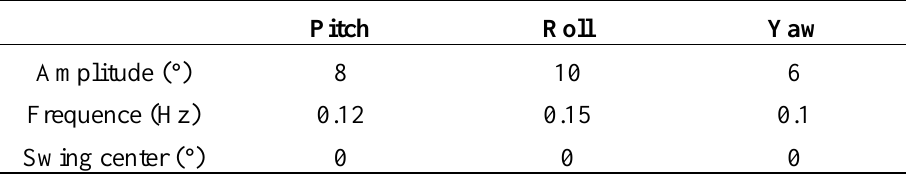
Table 10. Case 2 motion state of the